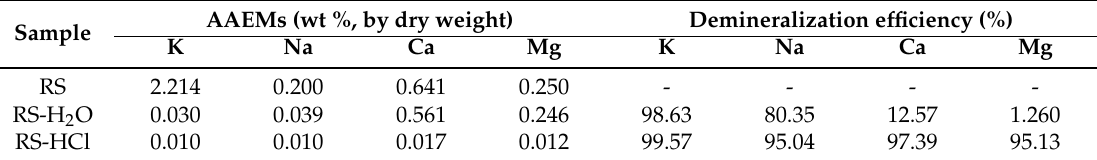
Table 2. Alkali and alkaline earth metallic species (AAEMs) content and demineralization efficiency of the